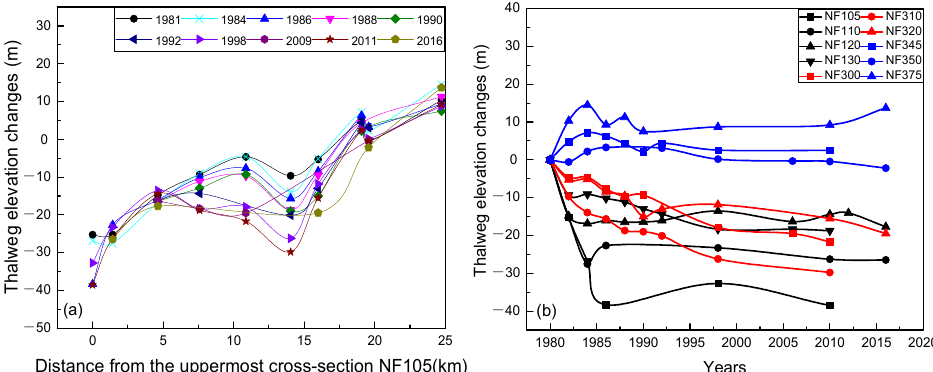
Figure 6. Adjustment of average measured slopes of NF120–375 cross sections.